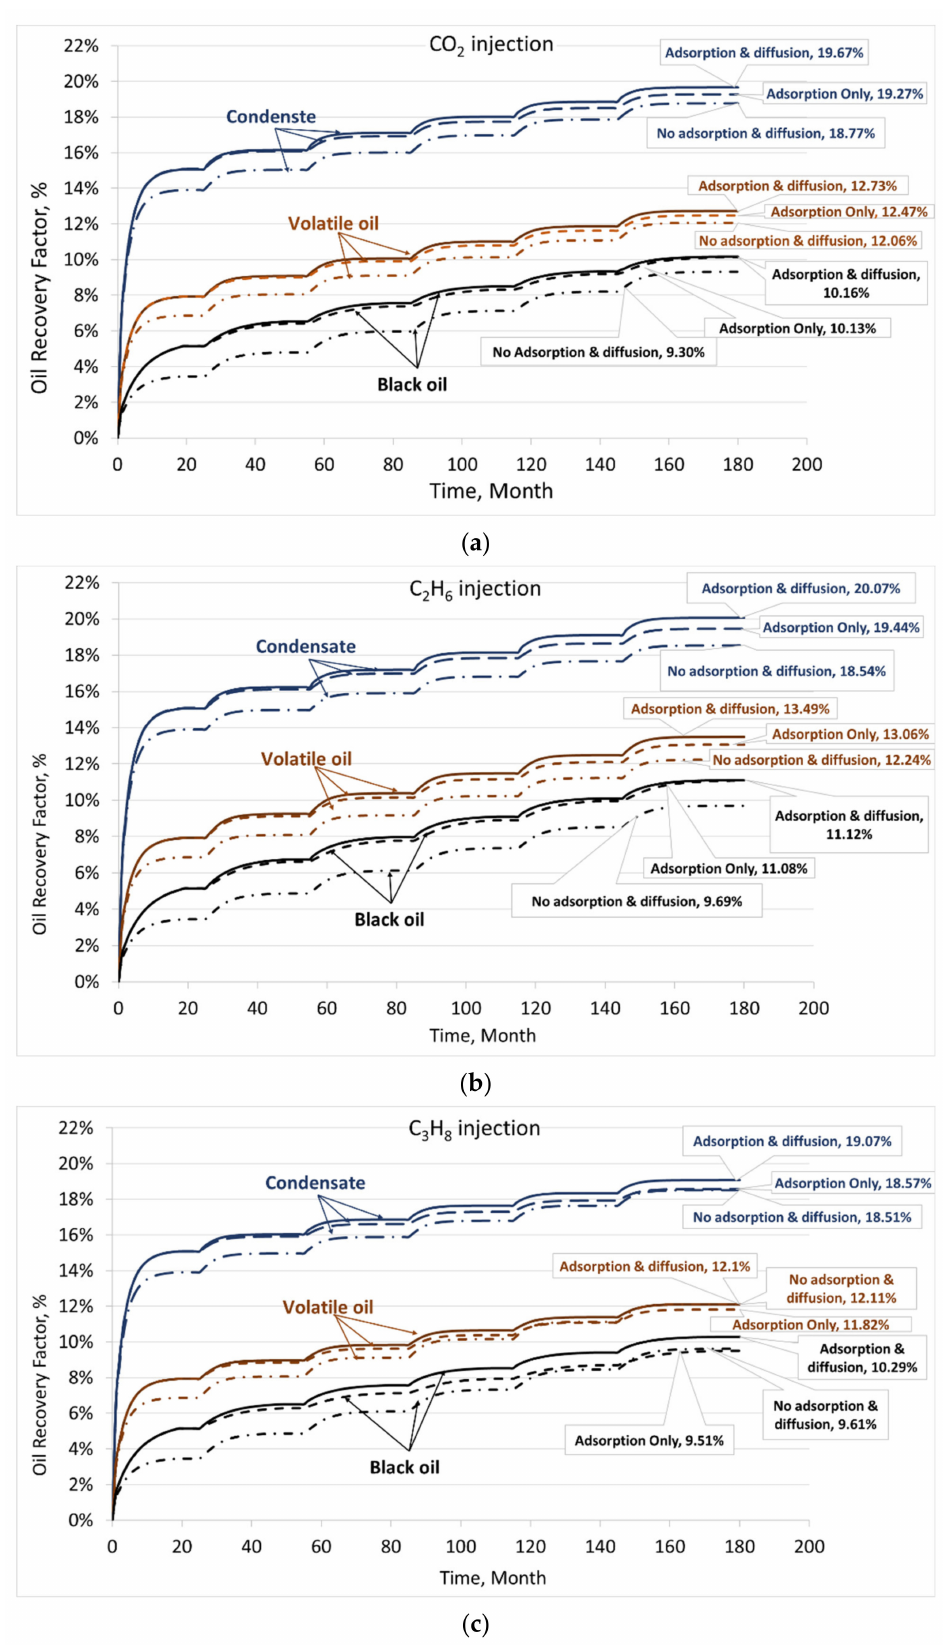
Figure 7. Huff-n-puff oil recovery for different fluid types when ( a ) CO 2 , ( b ) C 2 H 8 , and ( c ) C 3 H 8 are